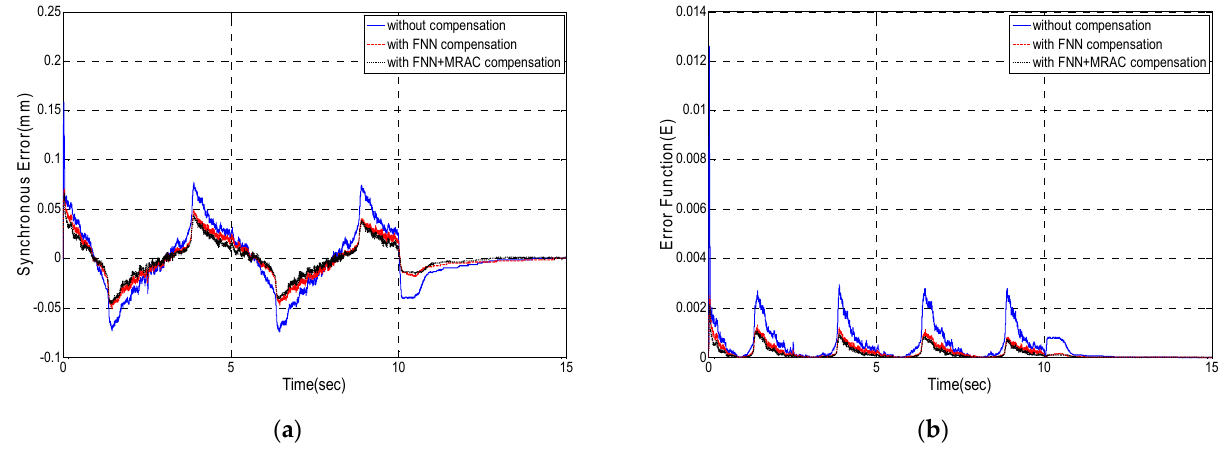
Figure 12. ( a ) The synchronous error under low-frequency commands; ( b ) the cost function under low-frequency commands.